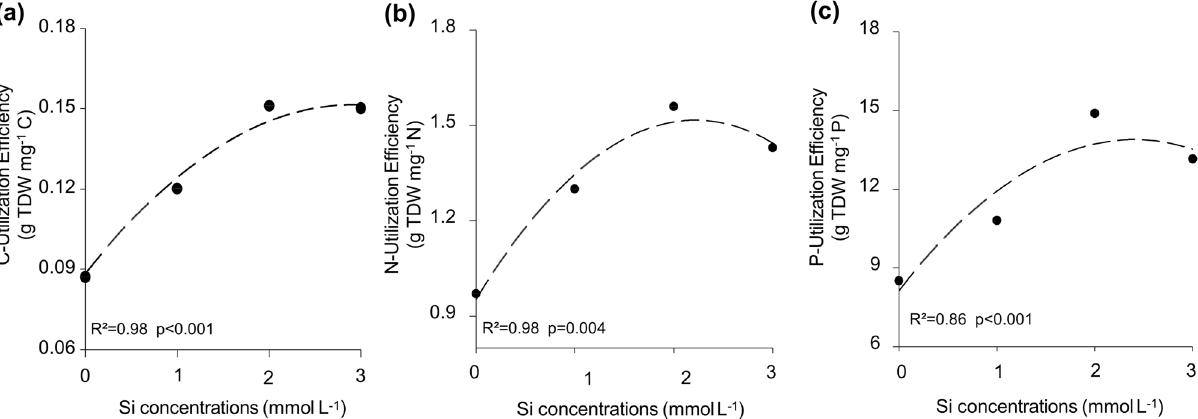
Figure 4. Use efficiency of carbon ( a ), nitrogen ( b ) and phosphorus ( c ) in quinoa plants for the studied Si concentrations.